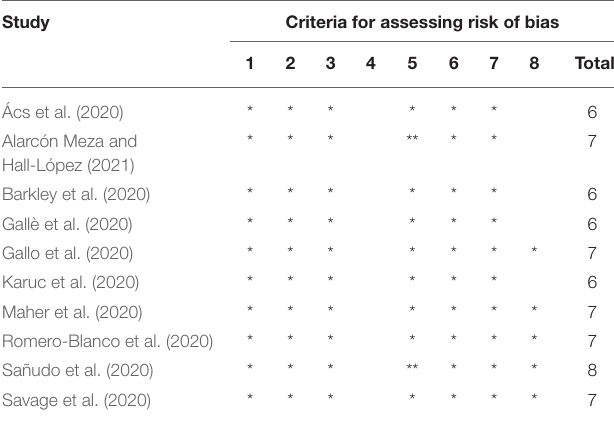
TABLE 2 | Risk of bias assessment of the studies (Newcastle-Ottawa scale).